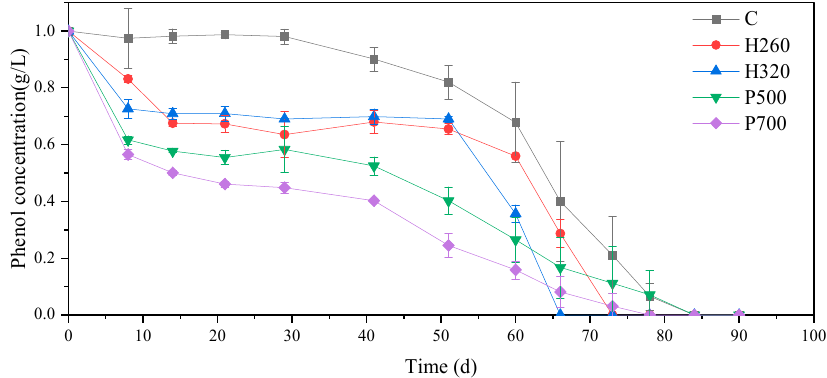
Figure 2. Changes of phenol concentration after adding H260, H320, P500, and P700.